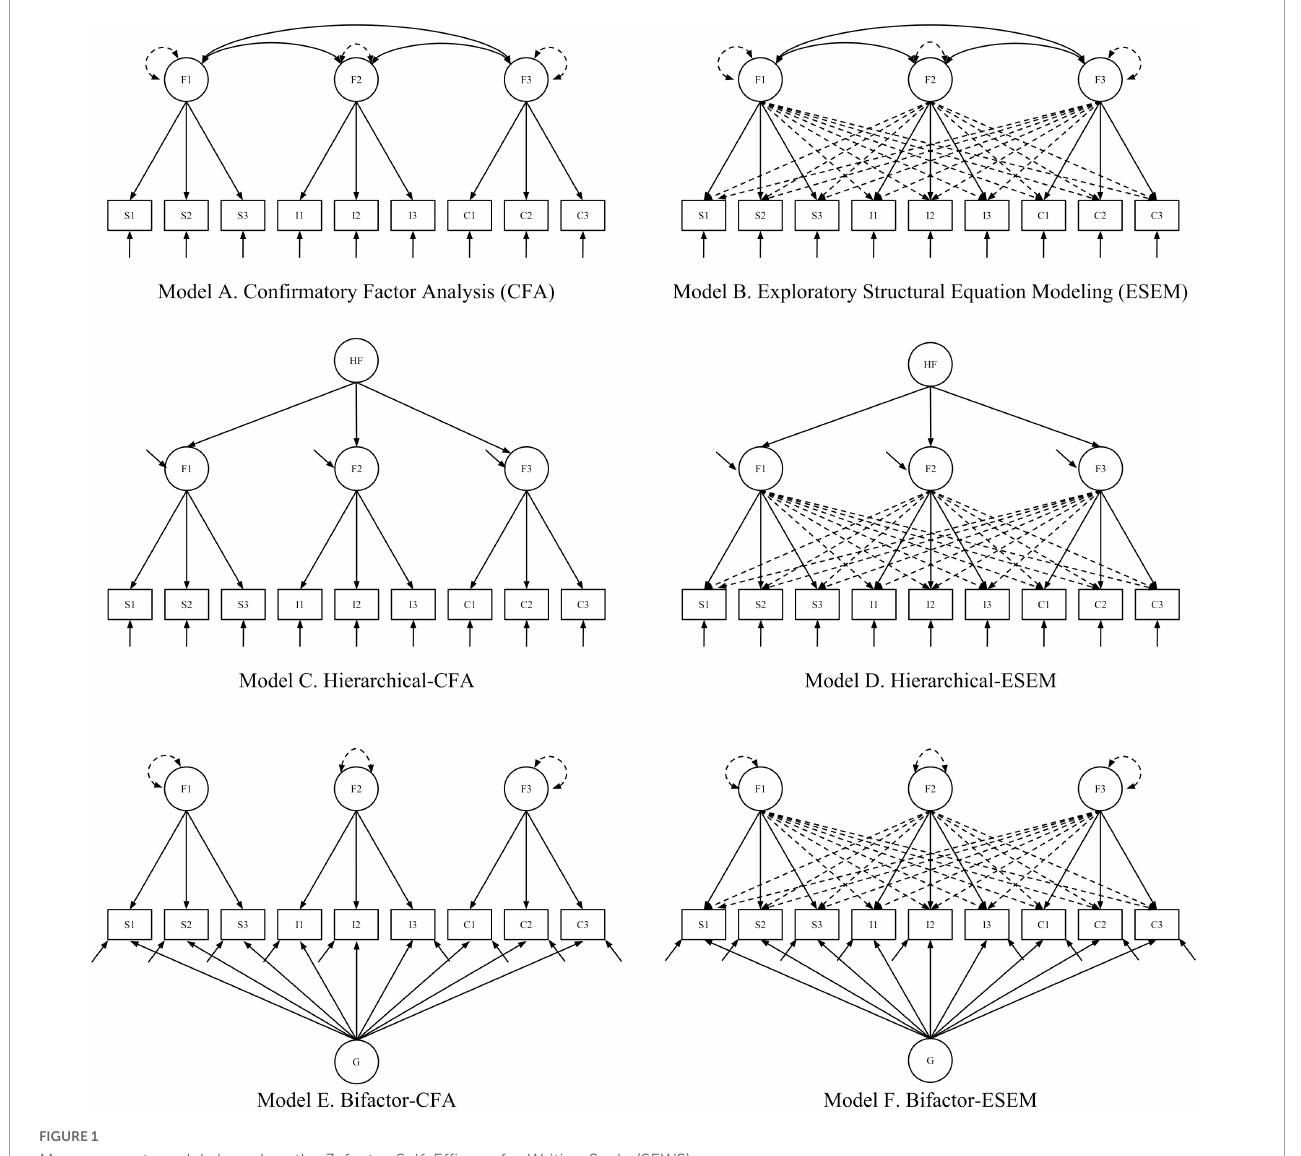
FIGURE1 Measurement models based on the 3-factor Self-Efficacy for Writing Scale